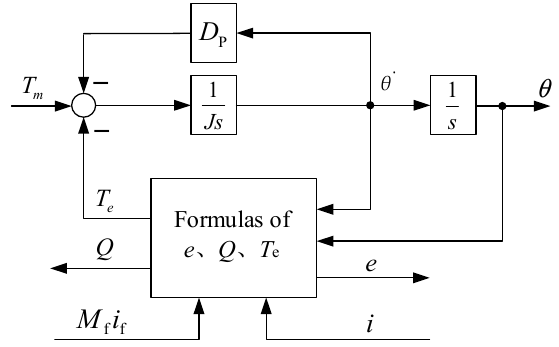
Figure 6. Mathematical model of the synchronous generator.